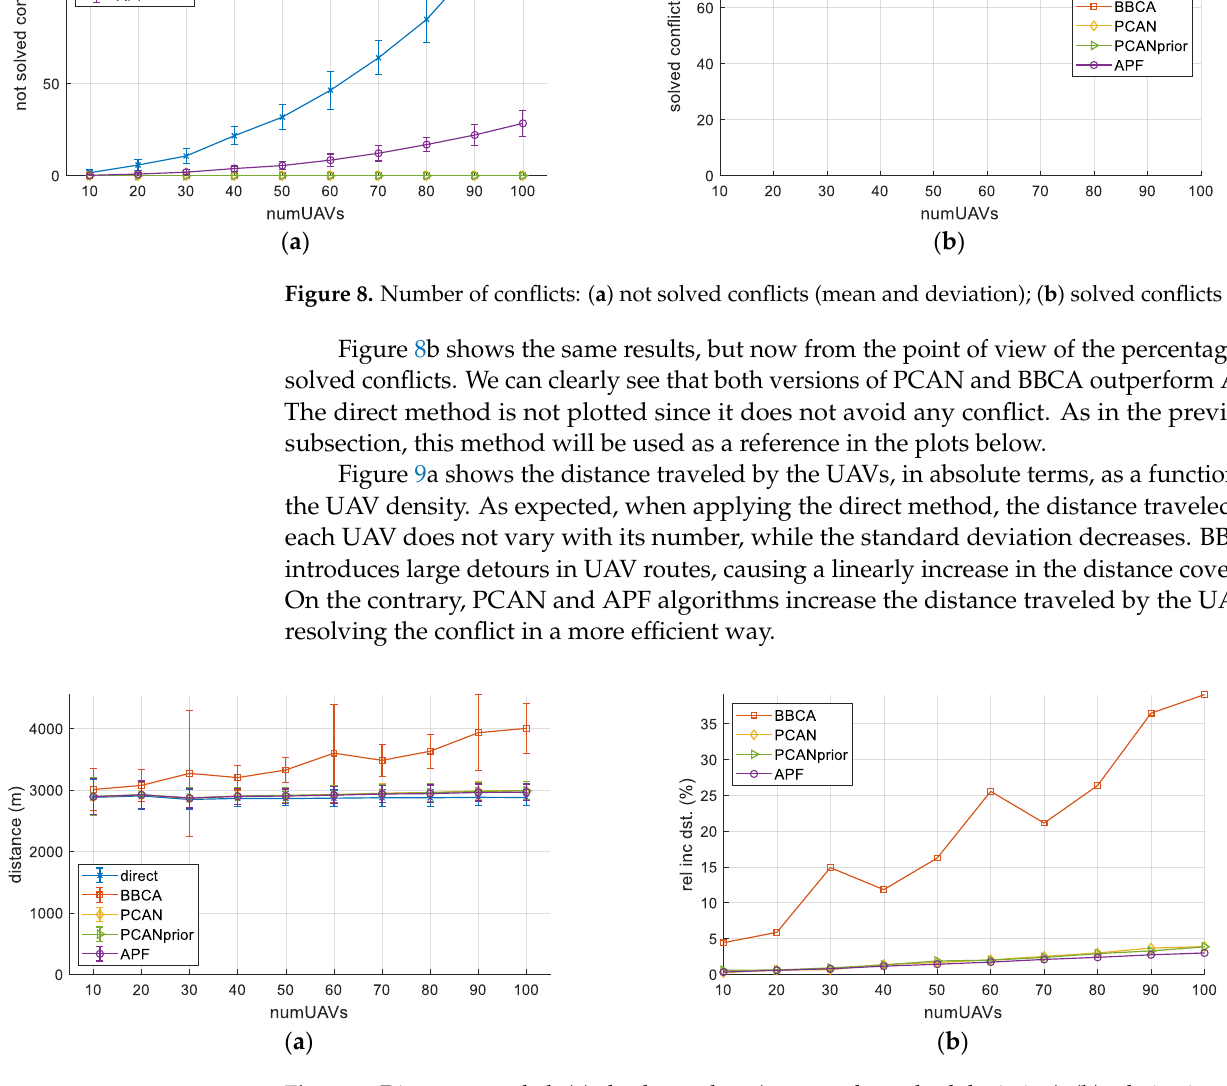
Figure 9. Distance traveled: ( a ) absolute values (mean and standard deviation); ( b ) relative increase with respect to the direct algorithm.